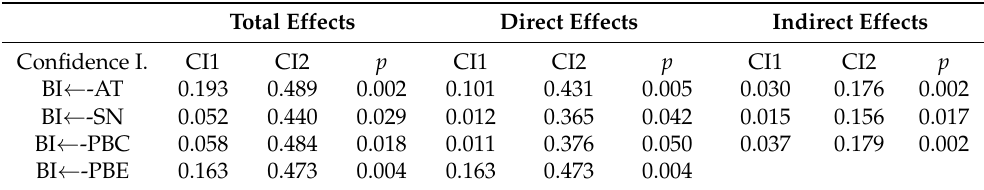
Table 5. Standardized effects of ANC and PBE on BI